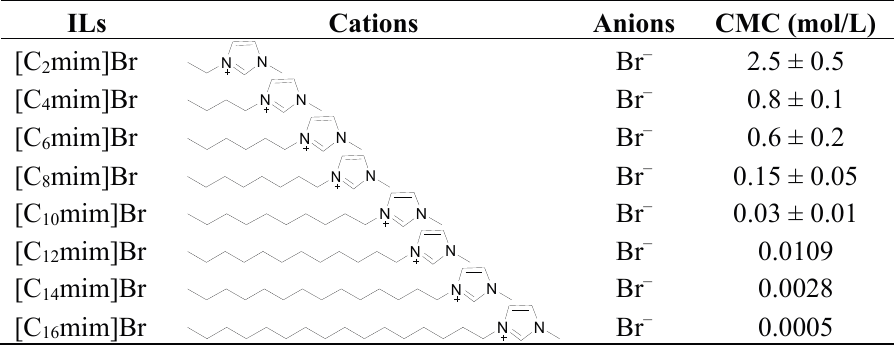
Table 2. The chemical structures and CMCs of the eight